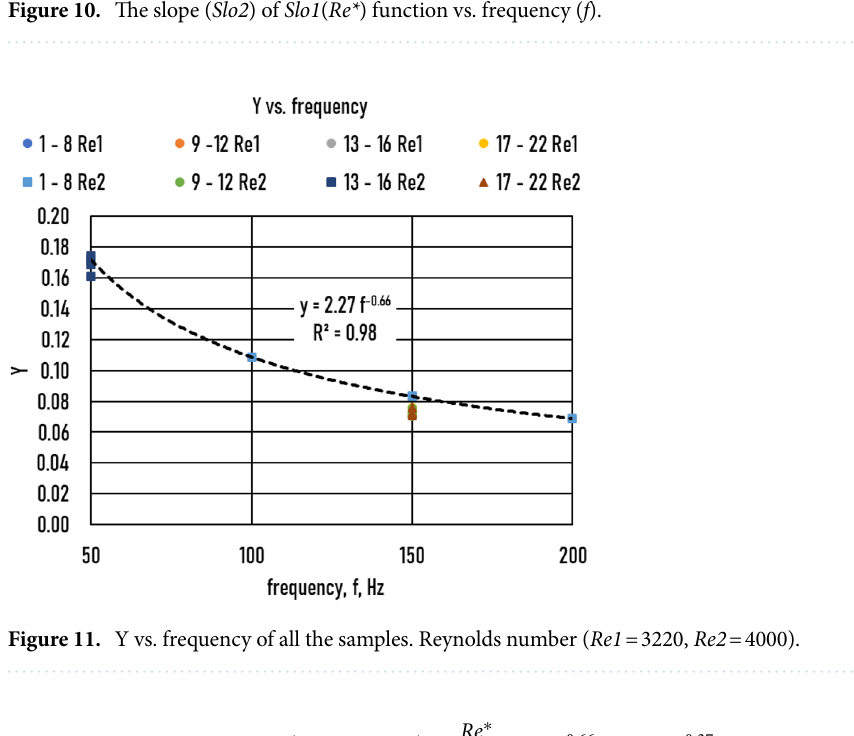
Figure 10. The slope ( Slo2 ) of Slo1 ( Re* ) function vs. frequency ( f ).